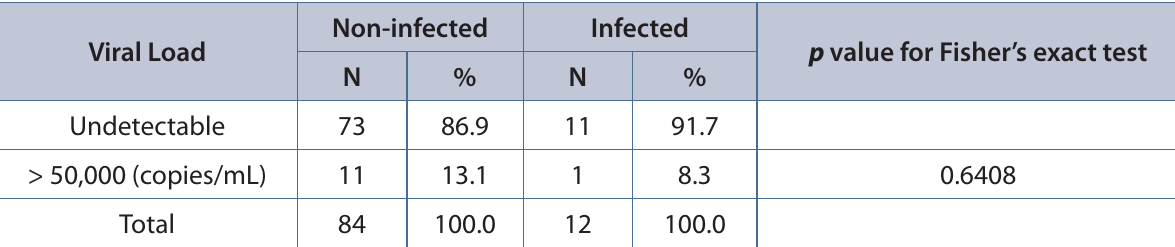
Table 3. Distribution of individuals with HIV/AIDS treated at the Specialized Outpatient Service and Day Hospital Professor Emeritus Domingos Alves Meira, UNESP, 2007-2008, according to detectable viral load and intestinal parasitic